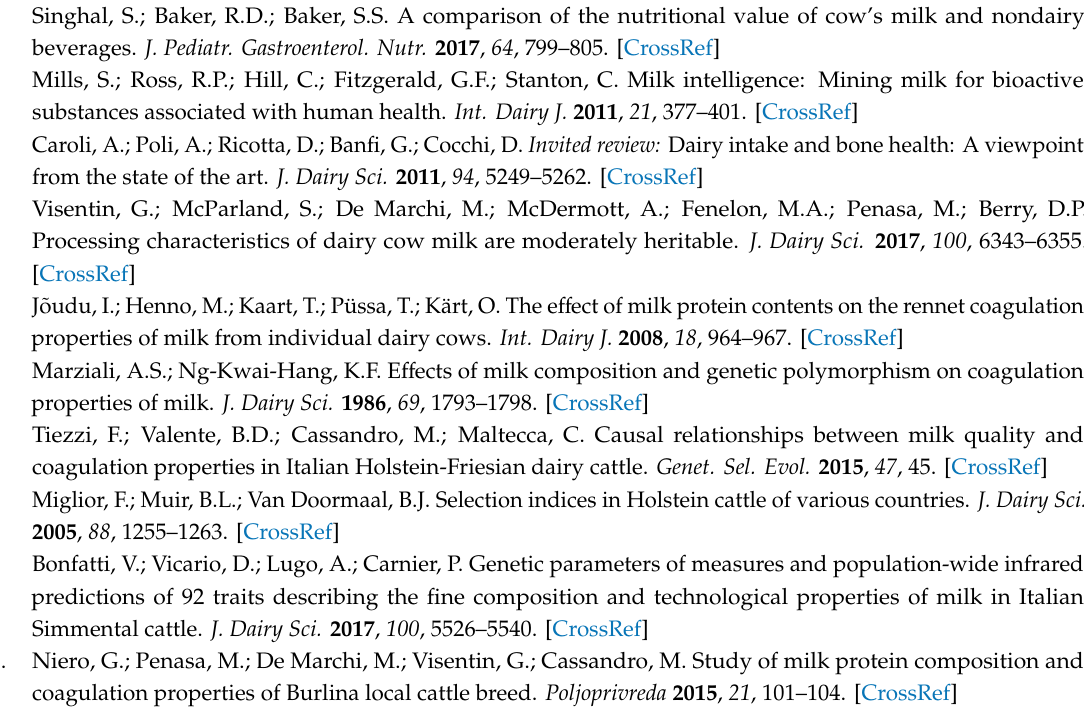
Figure S1: Least squares means of (a) crude protein (CP), (b) casein and (c) milk urea nitrogen (MUN) across parity for Brown Swiss (- (cid:7) -), Holstein-Friesian (- (cid:3) -), Alpine Grey (- (cid:52) -), Simmental (- (cid:8) -) and Pinzgauer (- × -) cows; Figure S2: Least squares means of (a) crude protein (CP), (b) casein and (c) milk urea nitrogen (MUN) across lactation for Brown Swiss (- (cid:7) -), Holstein-Friesian (- (cid:3) -), Alpine Grey (- (cid:52) -), Simmental (- (cid:8) -) and Pinzgauer (- × -) cows, Figure S3: Least squares means of (a) crude protein (CP), (b) casein and (c) milk urea nitrogen (MUN) across month of sampling for Brown Swiss (- (cid:7) -), Holstein-Friesian (- (cid:3) -), Alpine Grey (- (cid:52) -), Simmental (- (cid:8) -) and Pinzgauer (- × -)